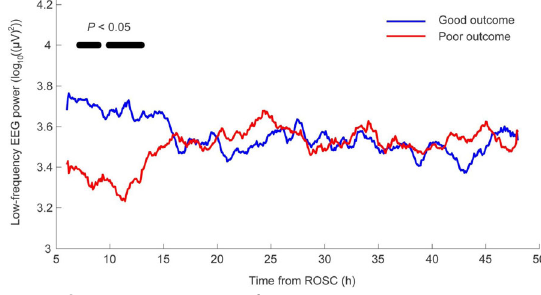
Fig. 1 (abstract 000934). Low-frequency EEG power in poor andgood outcome patients. The lines represent medians of groups afterreturn of spontaneous circulation